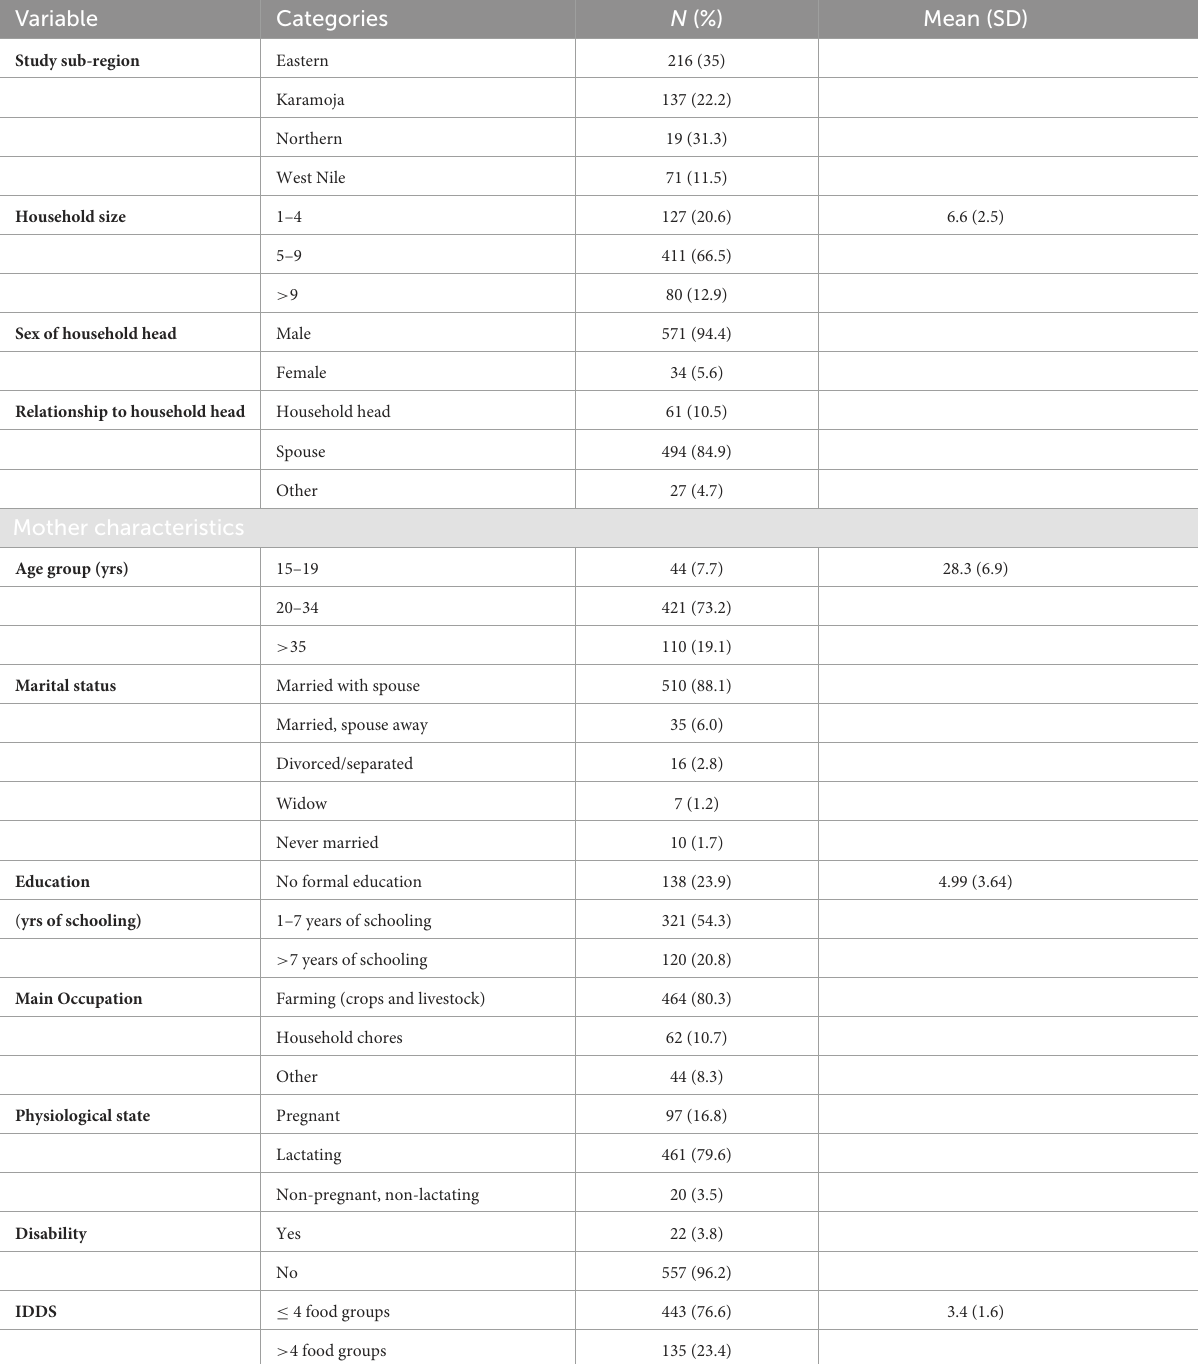
TABLE 1 Socio-demographic characteristics of households and